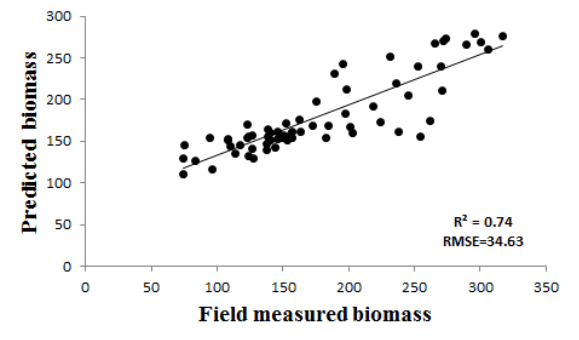
Figure 3 showed forest biomass estimation for each dominate forest type using waveform Lidar data. After stratification with forest type information, the R 2 improved 0.09 and 0.21 for broadleaf and coniferous species separately. As the mixed forest type has few plots, we use the combined equation for this